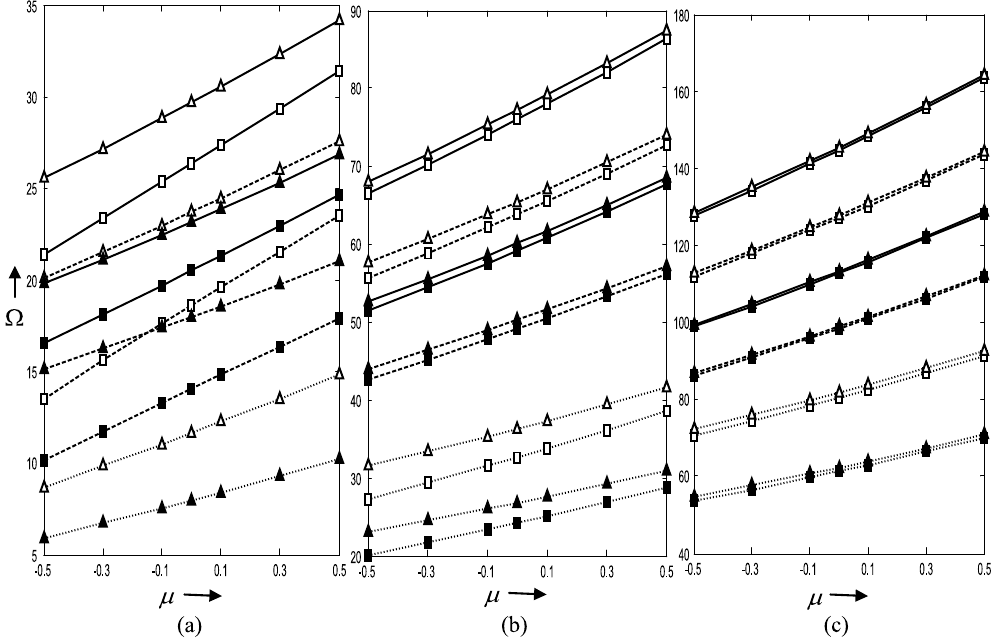
Fig. 6. Frequency parameter Ω for (a) first mode (b) second mode (c) third mode. _____, C-C; - - - - -, C-S; ......, C-F; N ∗ 0 = 30, γ = 1 ; (cid:3) , μ = 0 . 5 , β = 0 . 5 ; (cid:5) , μ = 0 . 5 , β = − 0 . 5 ; (cid:4) , μ = − 0 . 5 , β = 0 . 5 ; (cid:6) , μ = − 0 . 5 , β = − 0 . 5 .